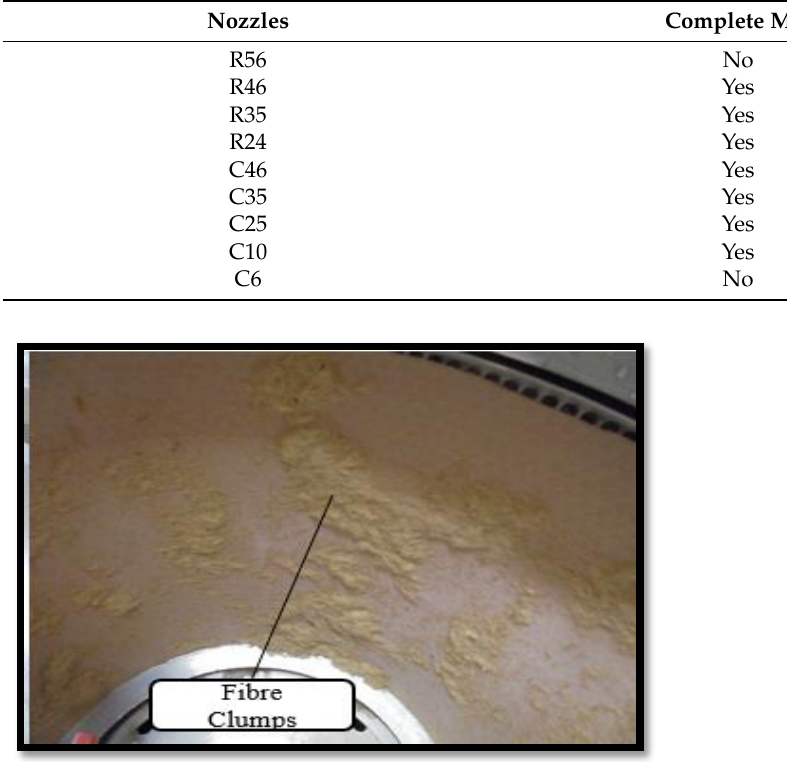
Figure 4. A complete hemp fibre mat produced using DSF (approx. 1000 mm × 300 mm × 0.80 mm). Table 3. Production of fibre mats using different nozzles. Table 3. Production of fibre mats using different nozzles.